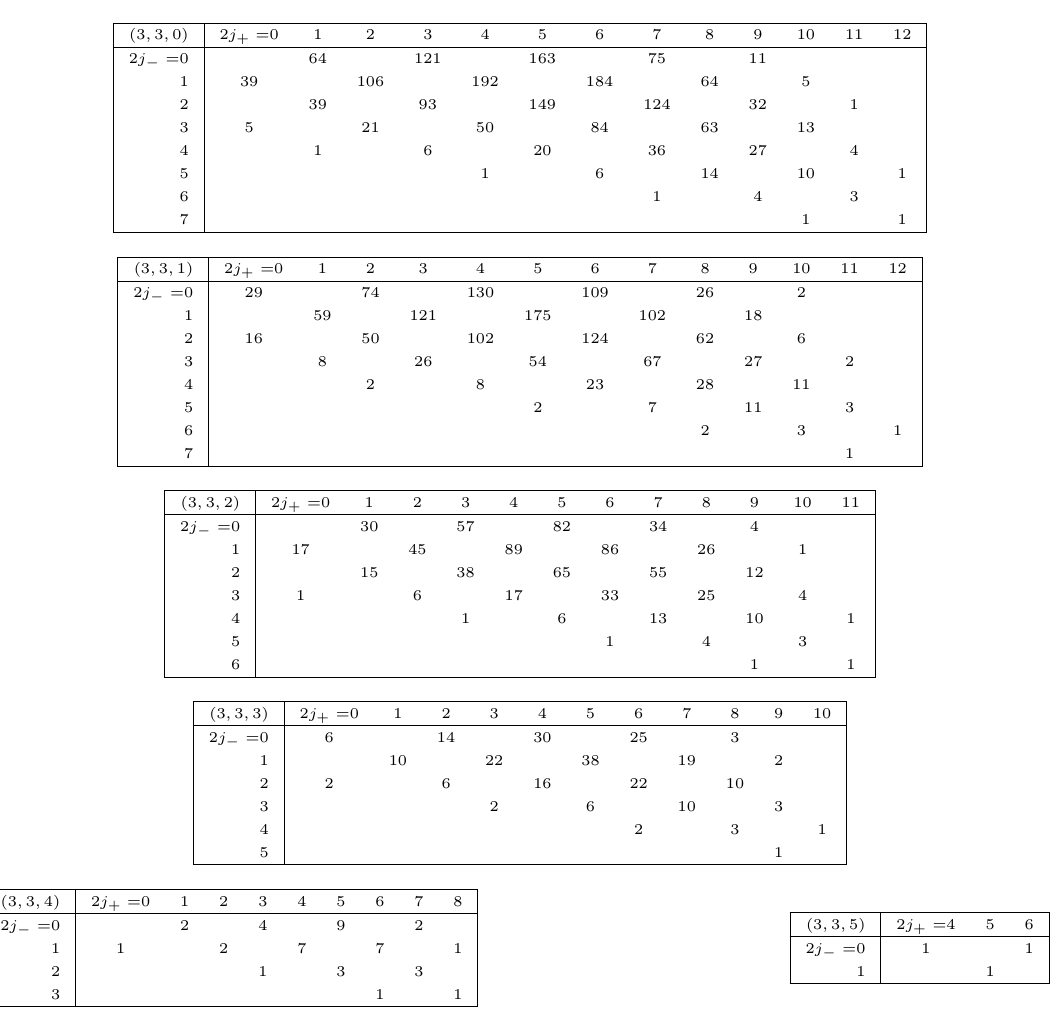
Table 18 . BPS numbers of massive M-string at base degree 3 and fiber degree